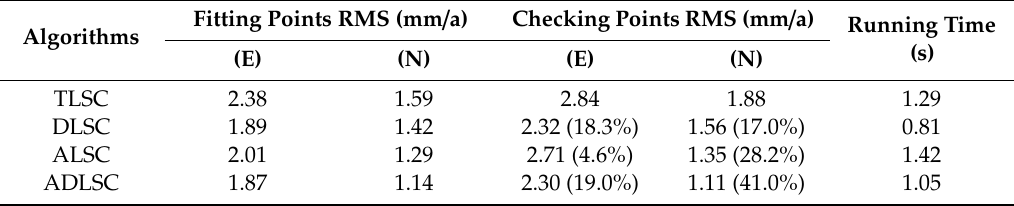
Table 4. RMS of the fitting points and checking points using four algorithms (Experiment 3).